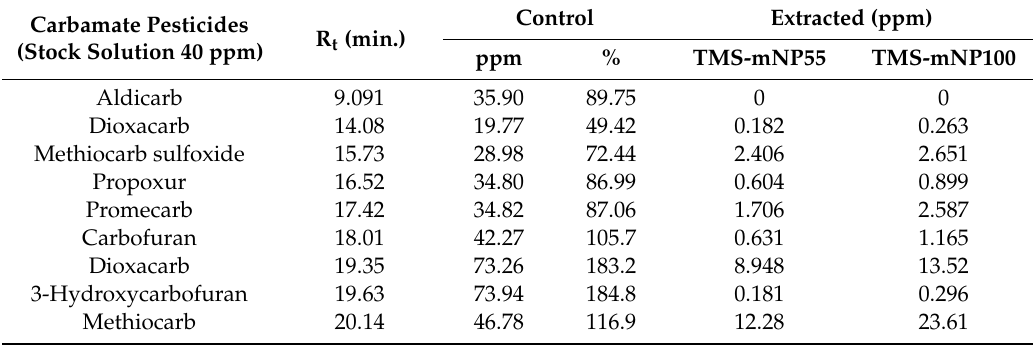
Table 5. The extracted concentrations of carbamate pesticides using TMS-mNP55 and TMS-mNP100 from 1.5 mL of the contaminated samples.